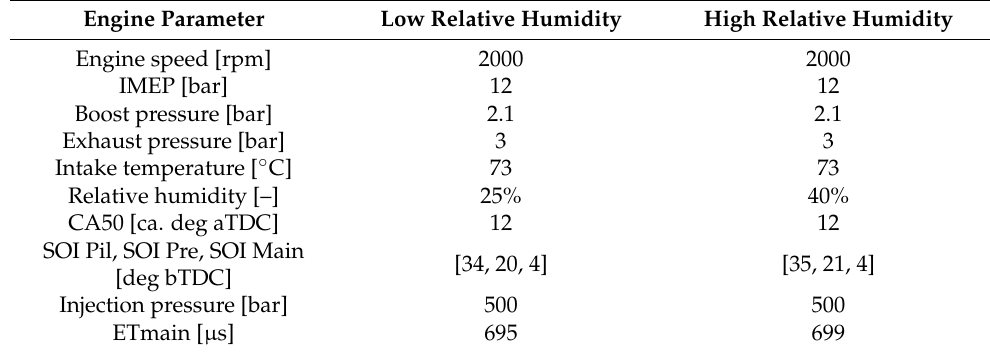
Table 5. Engine operating conditions testing the effect of two different relative humidity on